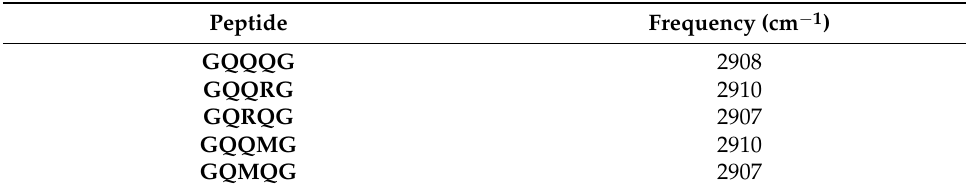
Figure 5. ATR deconvolution spectra of GQQMG pentapeptide in n -octanol. Table 3. Deconvolution of ATR peak of five pentapeptides to detect the C α —H ··· O hydrogen bond. The frequency calculated from quantum mechanics simulations was 2910 cm − 1 .